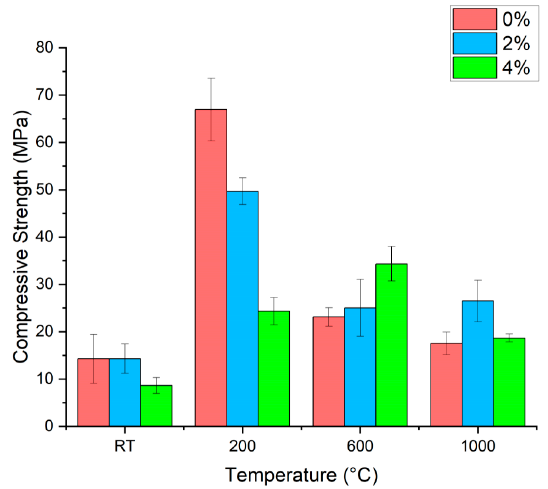
Figure 5. Compressive strength of fly ash geopolymers with varying silica fume content before and after exposure to elevated temperatures.